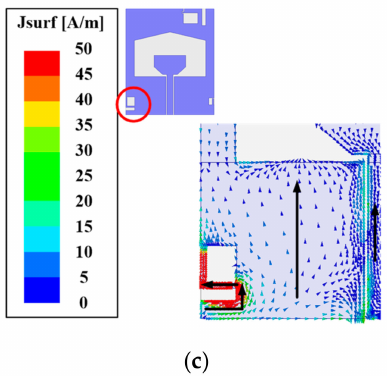
Figure 9. Simulated surface current distributions of NB Antenna #2 at three resonant frequencies ( a ) at 5.5 GHz, ( b ) at 6.52 GHz, and ( c ) at 7.65 GHz.